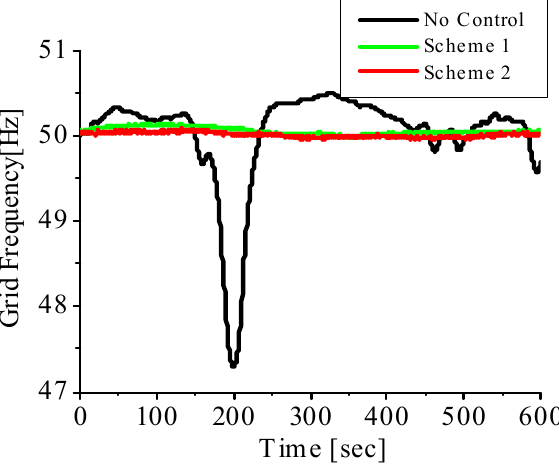
Figure 7. Grid frequency.